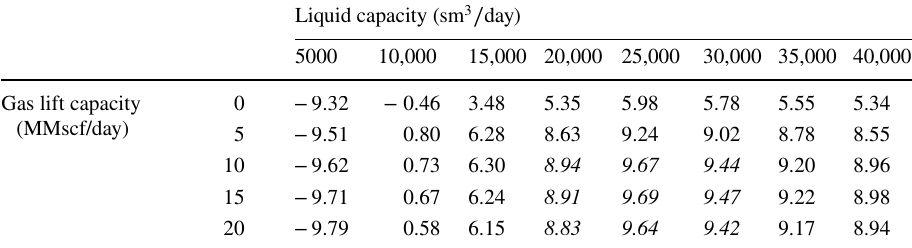
The numbers in italic indicate the sweet zone to be further